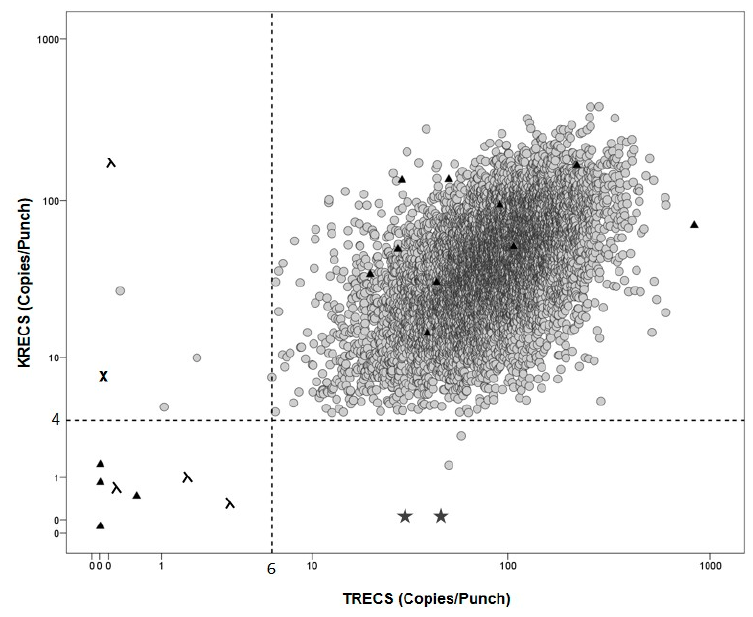
Figure 1. TRECS and KRECS values from DBS and controls grey: prospectively enrolled newborns; ▲ : CDC controls; λ : SCID controls; ★ : XLA controls; ✖ : AT control; grey dotted line : cut-offs for TRECs < 6 and KRECs < 4 copies/punch.